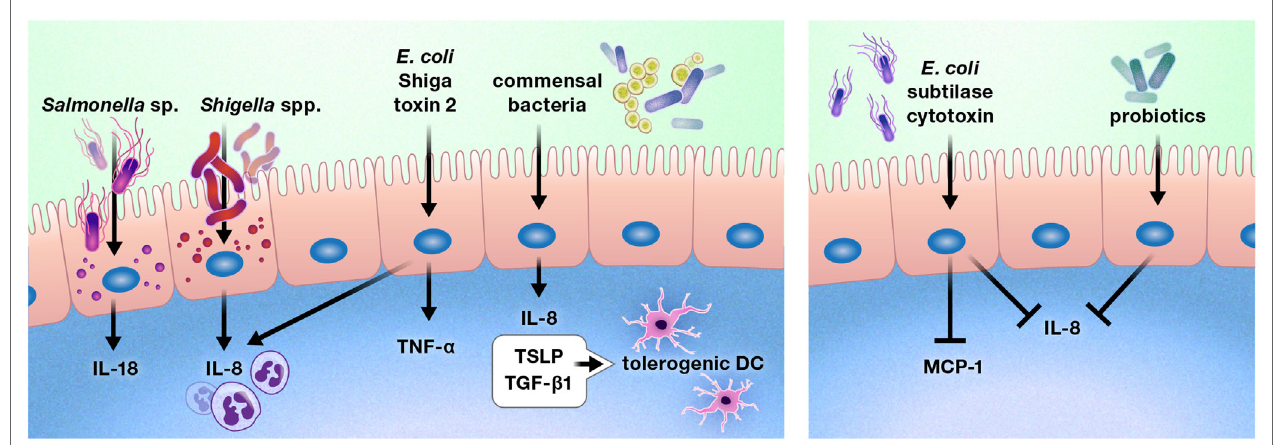
FiGURe 5 | Pathogens, commensal bacteria, and probiotics can increase or diminish the production of cytokines and chemokines by the intestinal epithelium. These interactions may promote or deter immune cell infiltration of the gut, such as by increasing or reducing the production of chemokines, including interleukin (IL)-8 and monocyte chemoattractant protein-1 (MCP-1). In some cases, bacterial interactions with the gut epithelium may instruct the intestinal immune system. For example, intestinal epithelial cells produce thymic stromal lymphopoietin (TSLP) and transforming growth factor- β (TGF- β ) 1 in response to commensal bacteria, inducing a tolerogenic phenotype in dendritic